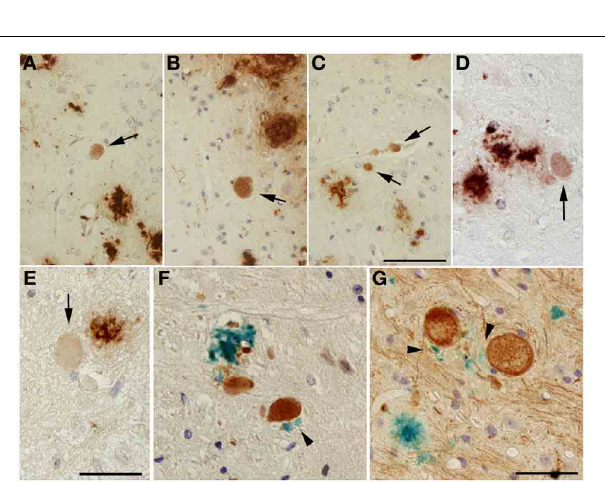
FIGURE 6 | A β -positive axonal swellings (arrows) (A–C). Axonal swellings were stained with 4G8 (A,B) , A β [N] (C) or end-specific antibodies detecting A β 40 (D) or A β N3pE (E) . Double immunostaining of A β (4G8, blue) together with either anti-pT668 (F) or NF-200 (G) (reddish brown). Small A β deposits (black arrowheads) could occasionally be detected in the vicinity of large dystrophic neurites in both APP/PS1KI he and APP/PS1KI ho mice. Scale bar: (A–C) : 50 μ m; (D,E) : 33 μ m; (F,G) : 12.5 μ